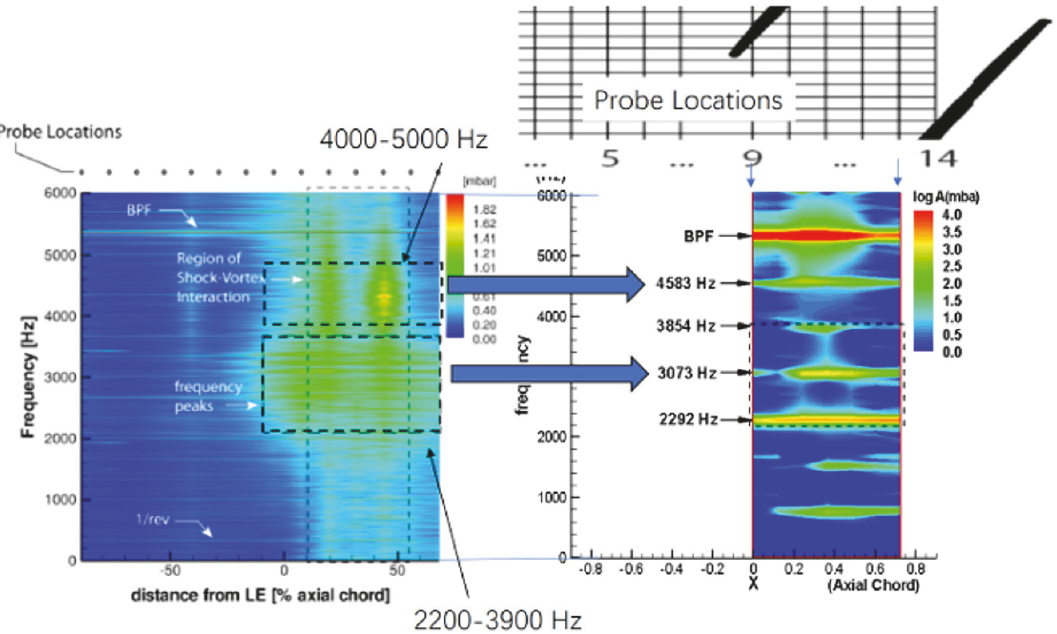
Figure 8: The comparison of frequency spectra between experiments (left) and simulations (right) at NS ([12]). Figure reproduced from LIN et al.